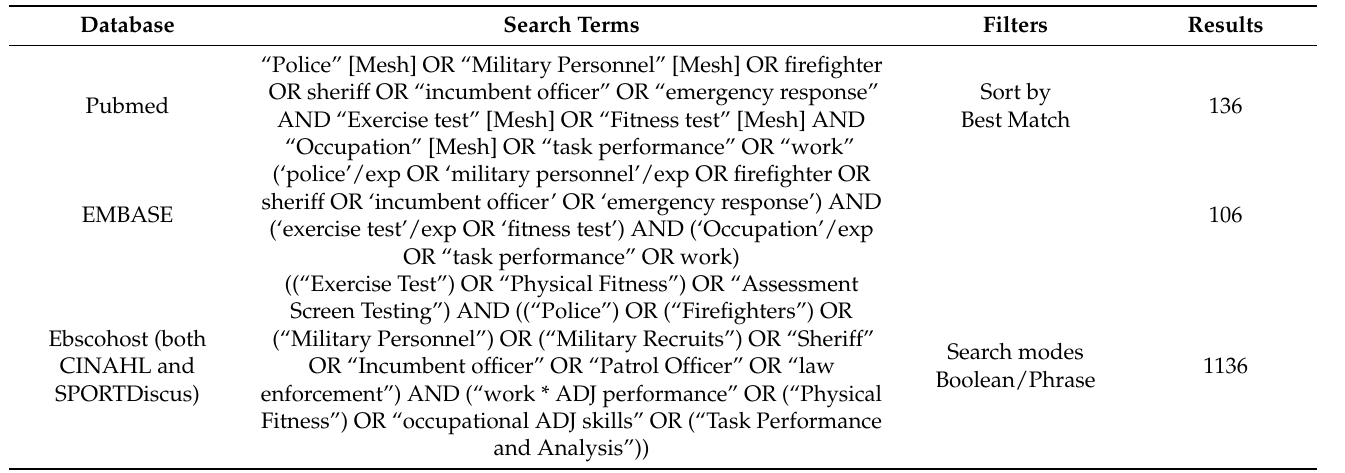
Table 1. Databases and Relevant Search Terms.